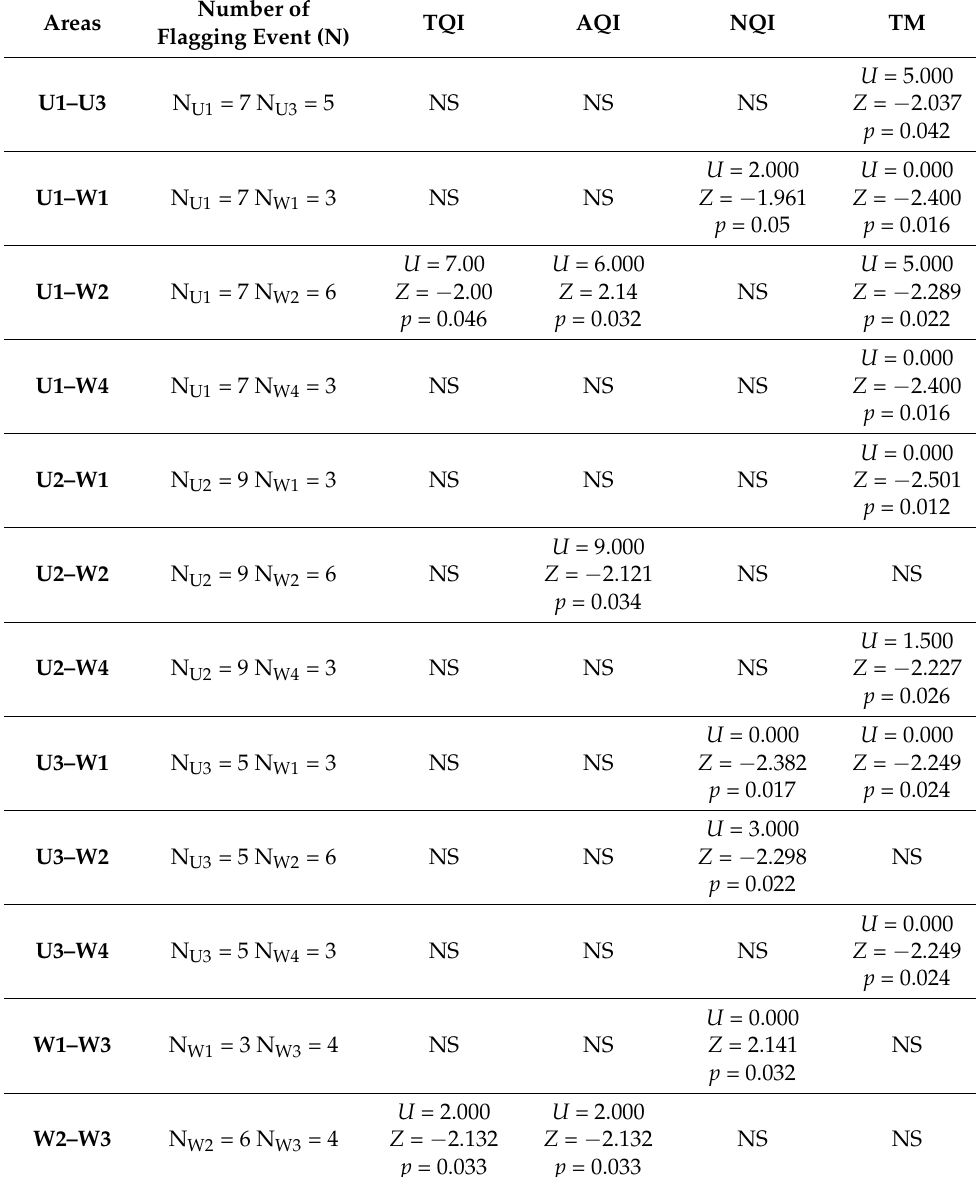
Table 4. Statistically significant differences ( p < 0.05) between urban and wild areas (Mann–Whitney